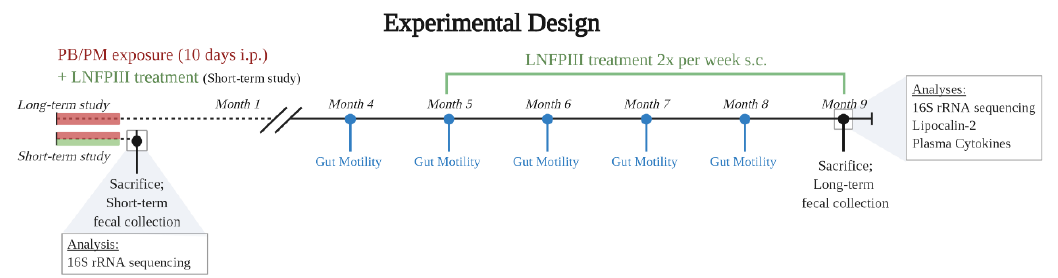
Figure 1. Experimental design. In both the short- and long-term studies, mice were exposed to pyridostigmine bromide (PB) and permethrin (PM) for 10 days for Gulf War Illness (GWI) induction. Lacto-N-fucopentaose-III (LNFPIII) treatment was given concurrently during the short-term study and beginning 4 months post PB / PM exposure in the long-term study. Gut motility was examined monthly from month 4 to 8. Microbiota sequencing of the 16S rRNA gene was performed in both the short- and long-term studies. Additionally, in the long-term study, lipocalin-2 (fecal, plasma) and cytokines (plasma) levels were examined.